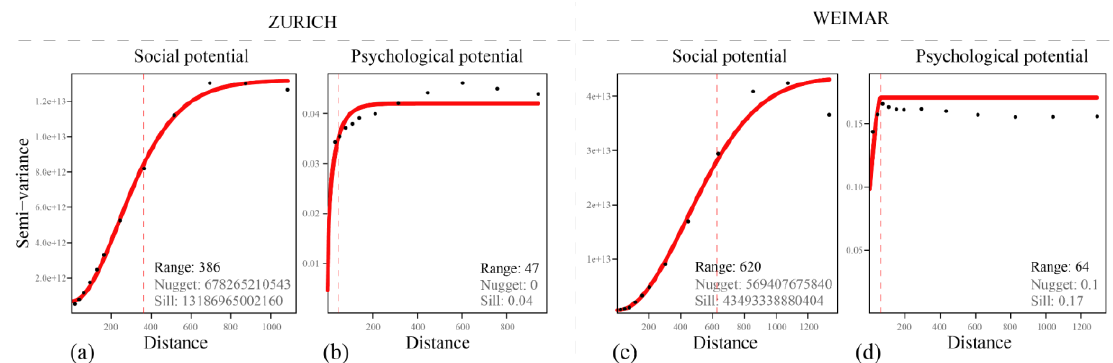
Figure 15. Semi-variogram curves fitted by Universal Kriging spatial interpolation method. ( a ) Social potential for Zurich, ( b ) Psychological potential for Zurich, ( c ) Social potential for Weimar, and ( d ) Psychological potential for Weimar.